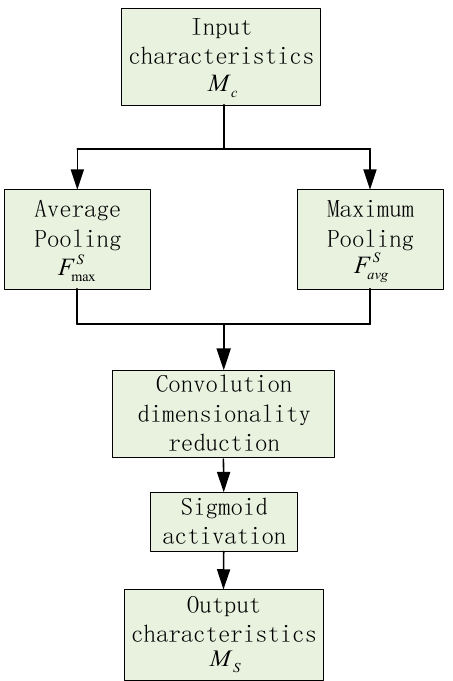
Figure 6. Basic structure of the spatial a tt ention model.